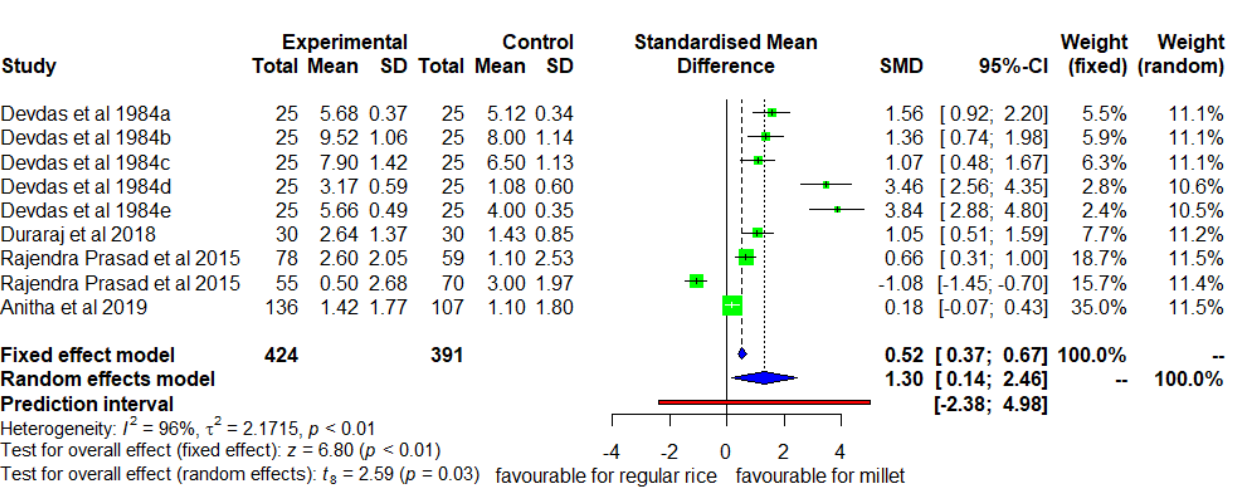
Figure 2. Effect of consuming a millet-based diet on mean height change compared to a regular rice-based diet.